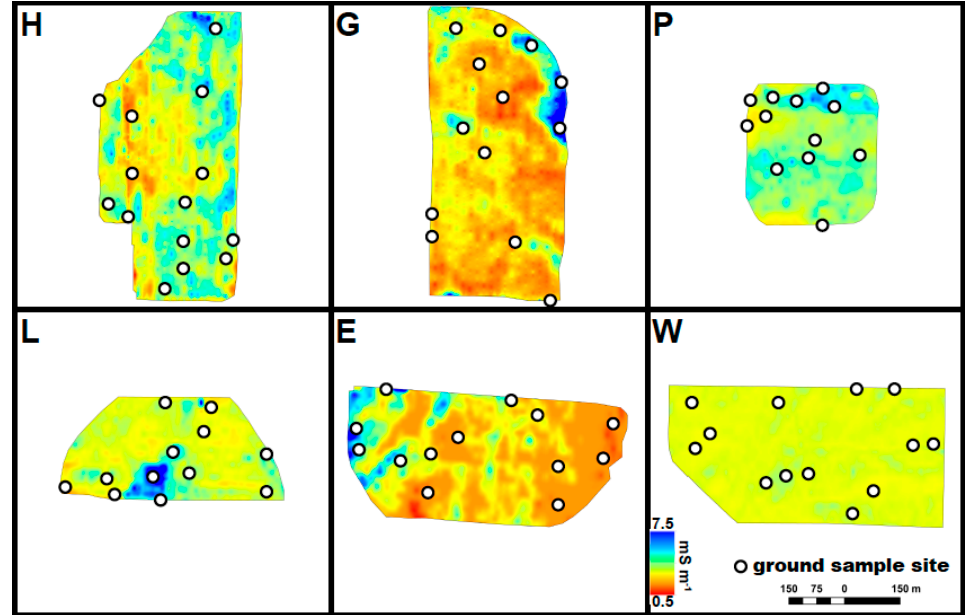
Figure 2. Maps of apparent soil electrical conductivity (EC a ), as adapted from Nocco et al., 2019. Field labels refer to Figure 1; EC a surveys were conducted on in 13 April 2015 for fields P, L, E, W and on 21 April 2016 for fields H and G.